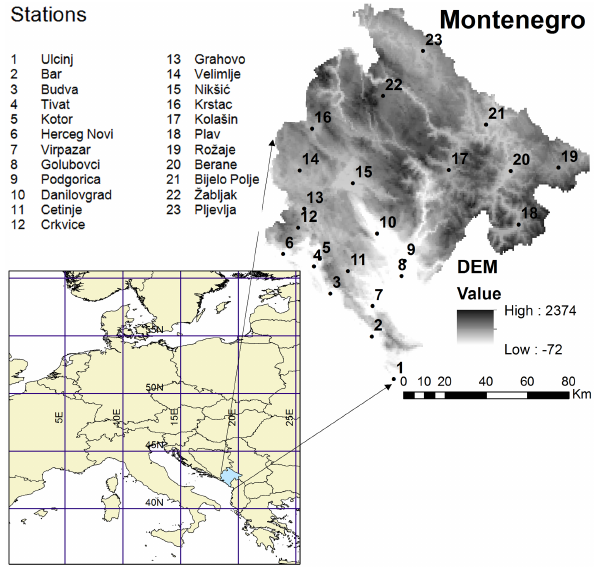
Figure 1. Locations of the stations and elevation of Montenegro.